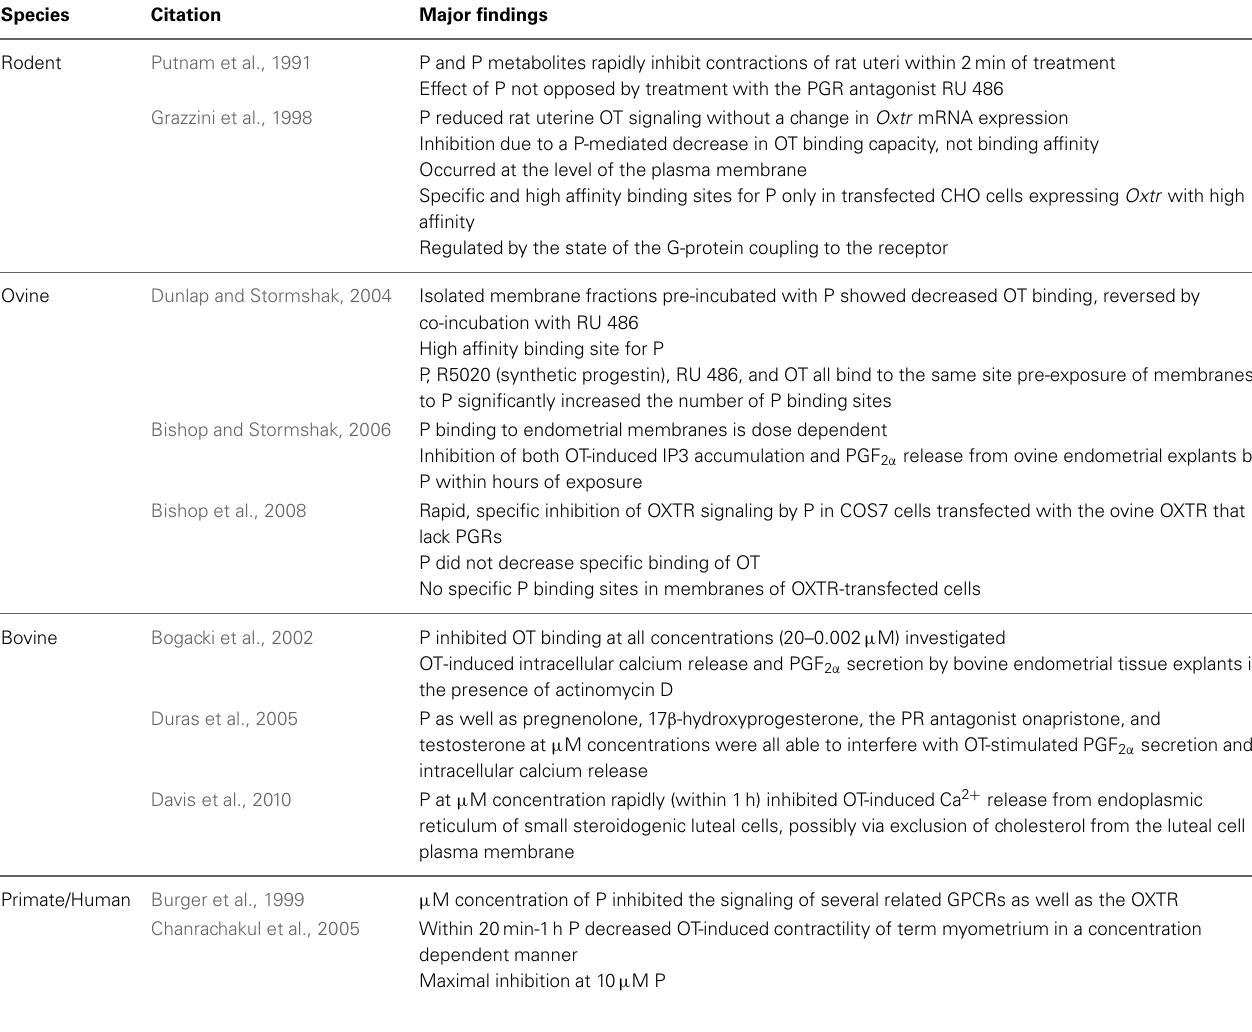
Table 1 | Studies of progesterone inhibition of OXTR